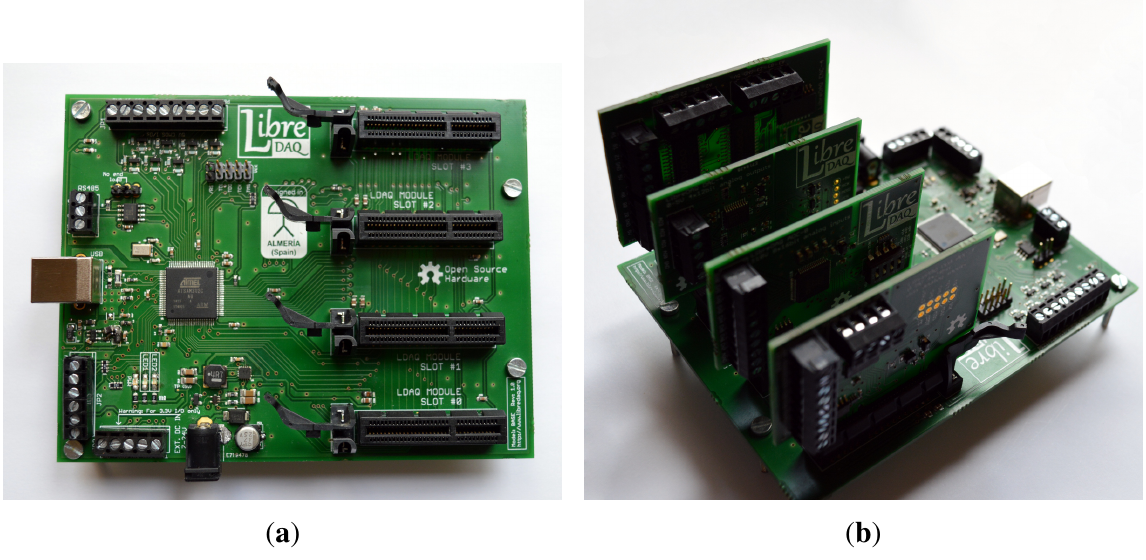
Figure 2. A prototype of the proposed system. ( a ) The base controller board, with the four empty slots at the right-hand side; ( b ) Base board with all its four slots populated with DAQ